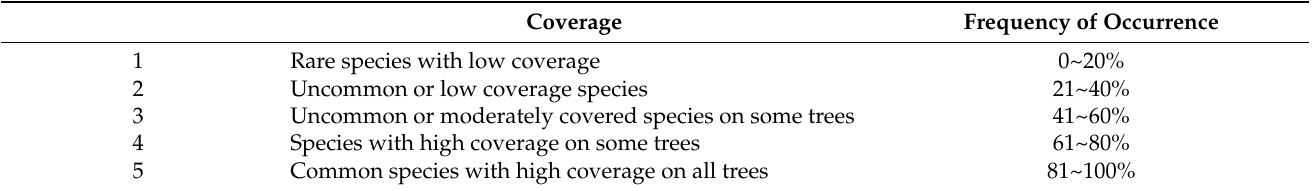
Table 4. Subjective estimation of epiphytic coverage and occurrence